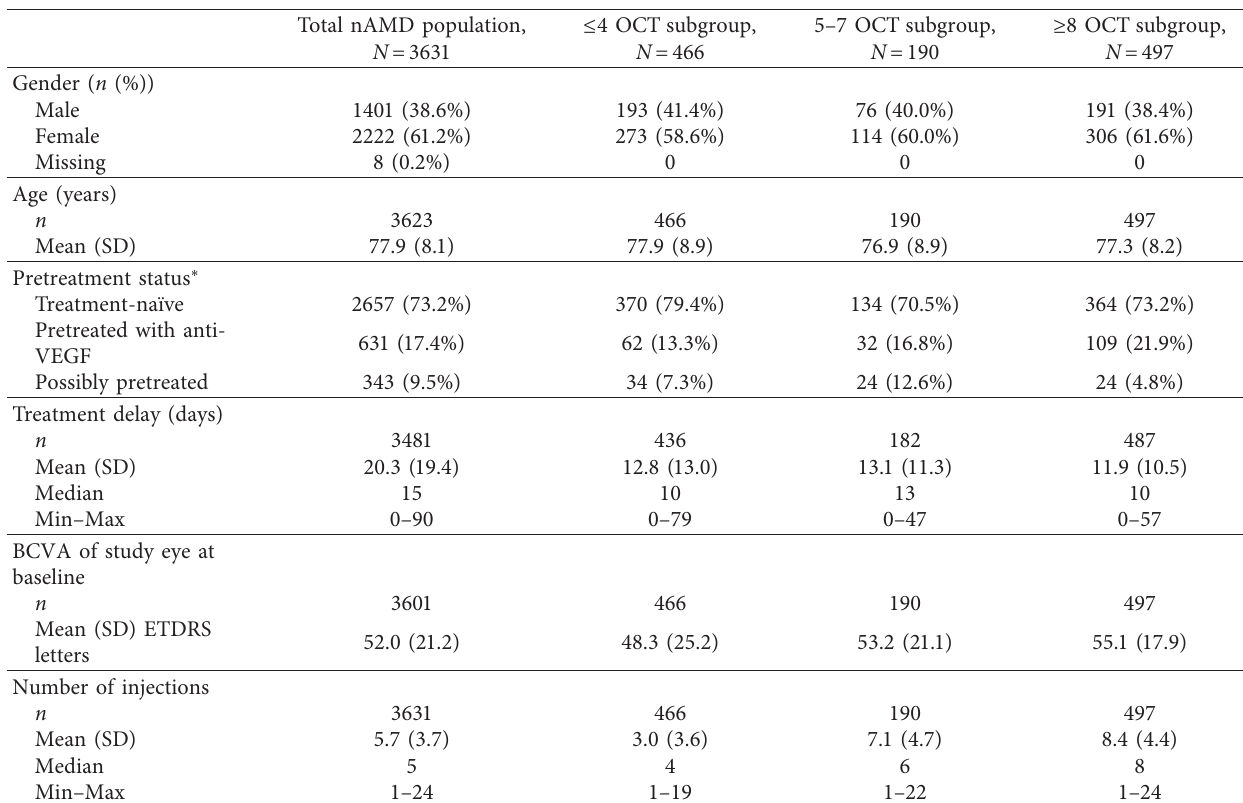
Table 1: Patient demographics and baseline disease characteristics of OCEAN nAMD population and the three OCT examinations subgroups.